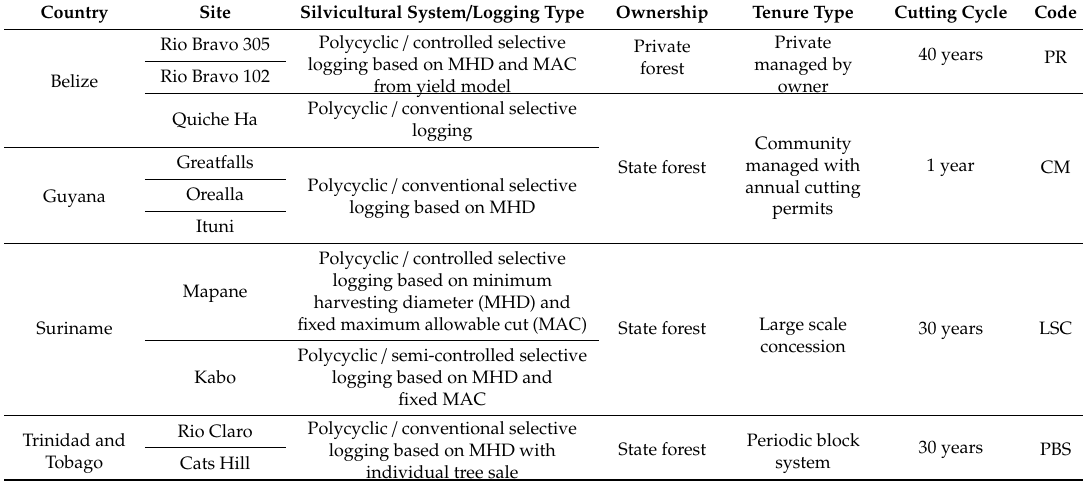
Table 1. Sites and tenure